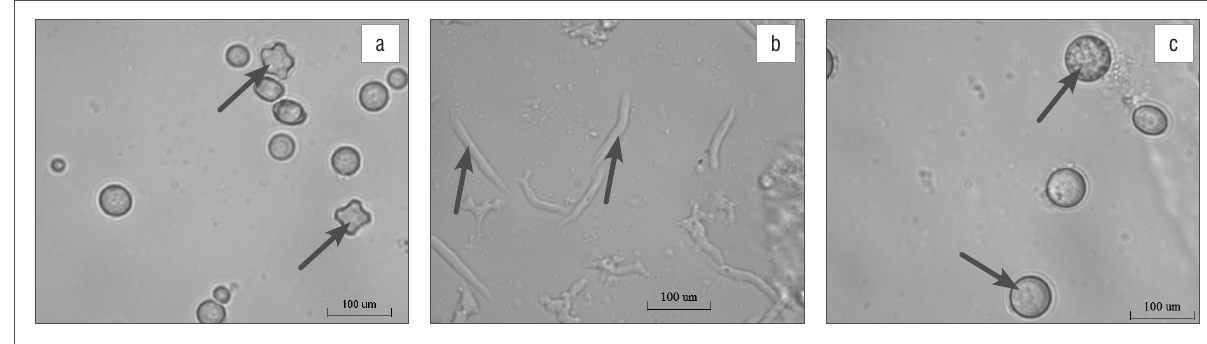
Figure 1: (a) Acanthamoeba cysts, (b) Hartmanella trophozoites and (c) Balamuthia cysts (all indicated by arrows) in water and biofilm samples from a hospital water system. Table 1: Biodiversity of free-living amoeba from different sampling sites in a hospital water system Sampling site Acanthamoeba spp. Other free-living amoeba † Hartmanella spp. Balamuthia spp. (+) (%) (+) (%) (+) (%) (+) (%) Theatre and central sterilisation service units 3 (37.5) Endoscopy/bronchoscopy